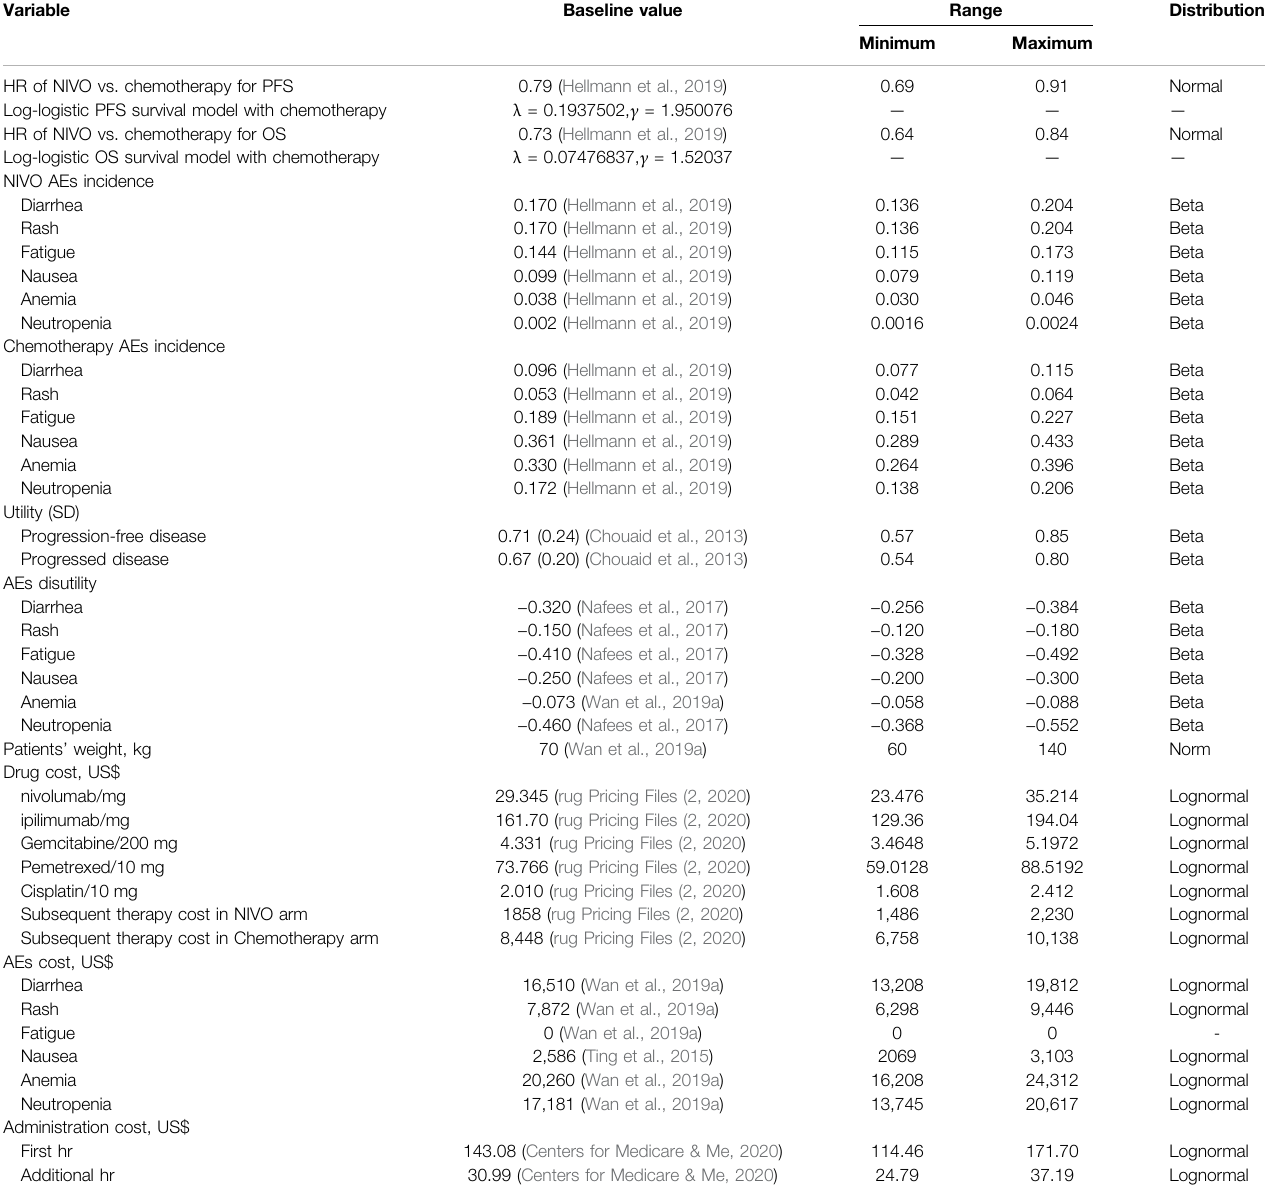
TABLE 1 | Model parameters. Variable Baseline